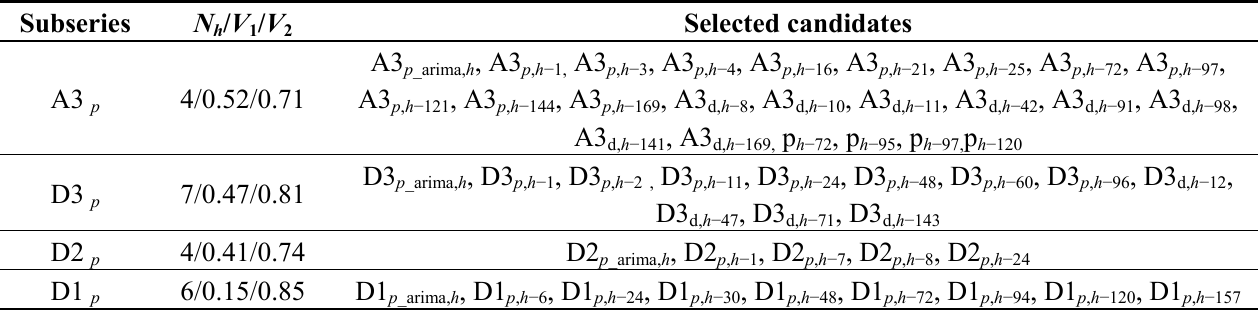
Table 3. Inputs selected by the two-step feature selection to predict the normal price wavelet components for the NN for a single forecast day, 5 January